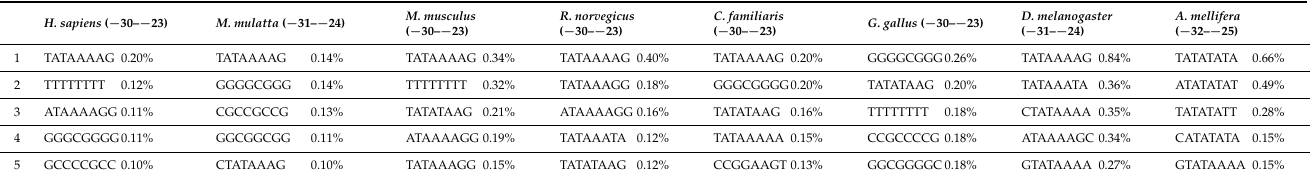
Table 1. Frequencies of occurrence of different octanucleotides in TATA-box position of every studied organisms (for the exception of S. cerevisae